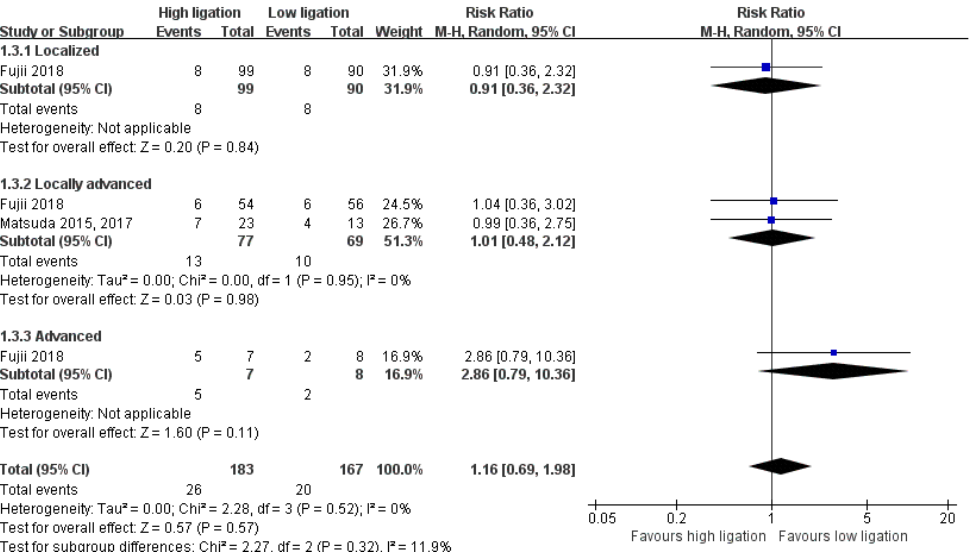
Figure 7. Forest plot of the subgroup analysis for 5-year overall mortality .